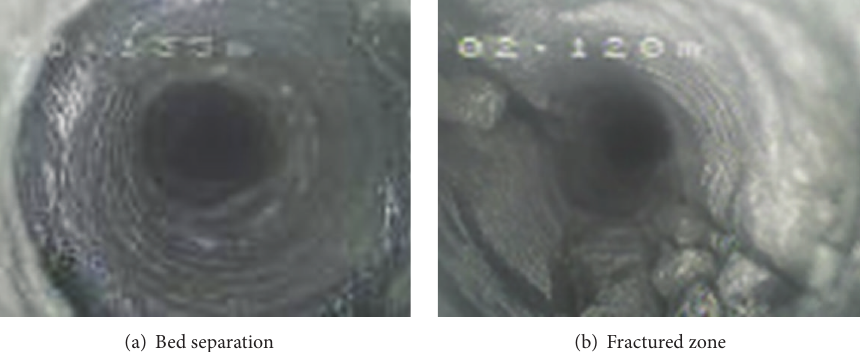
Figure 4: Evolution of fissures into bed separation and a fractured zone.